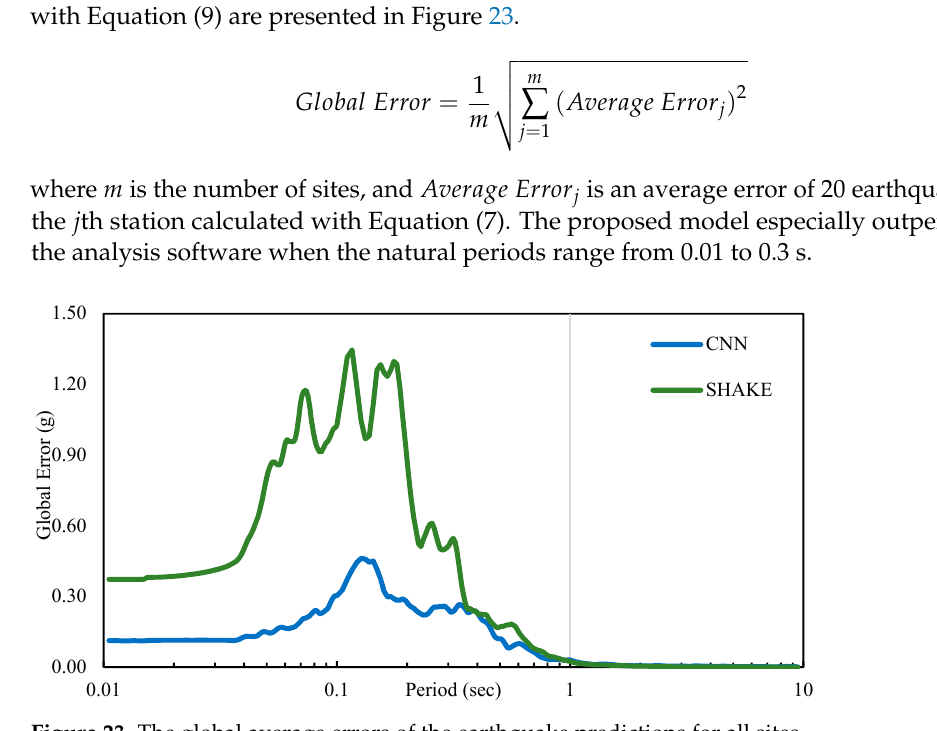
Table 3. Average mean squared error of the proposed model and SHAKE2000.